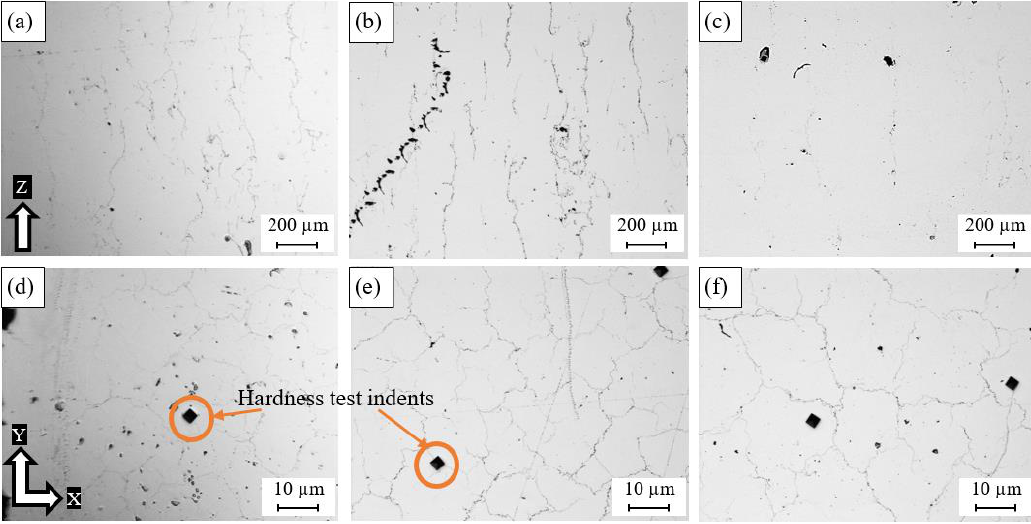
Figure 6. Pores observed inside the as-built Al6061 samples processed through different SLM parameters; ( a , d ) 8A, ( b , e ) 4A, and ( c , f )